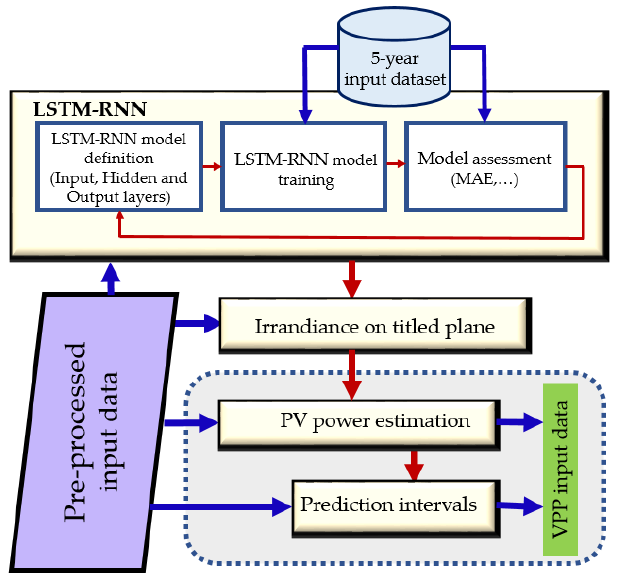
Figure 4. Flowchart for the LSTM-RNN-based forecasting model design. Table 1. Parameters selected in the LSTM-RNN.